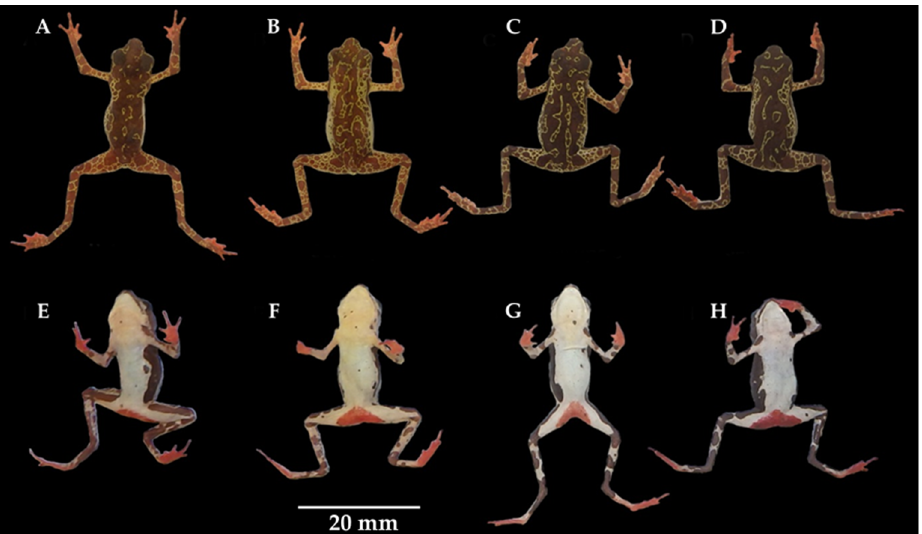
Figure 5. Ventral view of the foot of Atelopus manauensis sp. nov. in preservative: ( A ) allotype; ( B ) holotype.